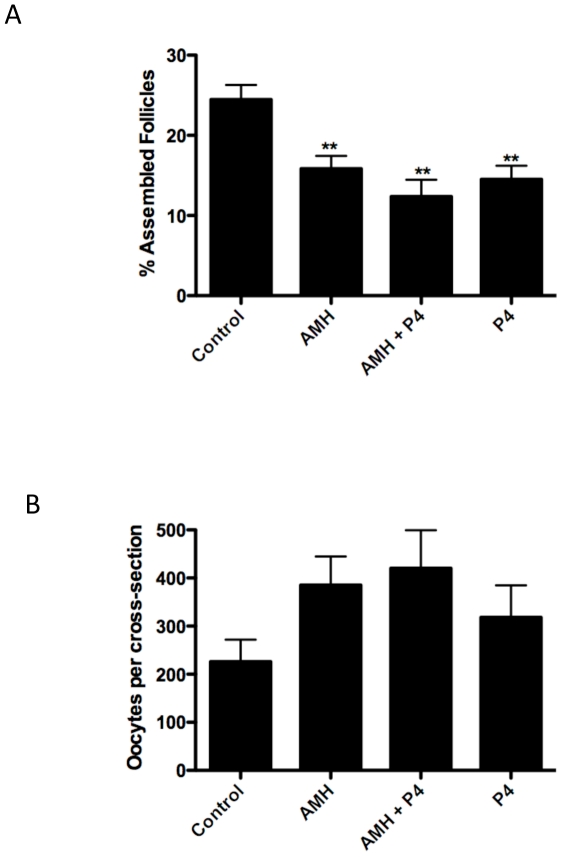
Primordial follicle assembly after 2 days of treatment (A) represented as % Assembled Follicles after AMH, progesterone (P4) and AMH combined with P4 treatments.Oocyte number per cross section (B) after the same treatments. The Mean ±SEM from a minimum of five different experiments performed in replicate with statistical significance indicated as (**) (P<0.01).